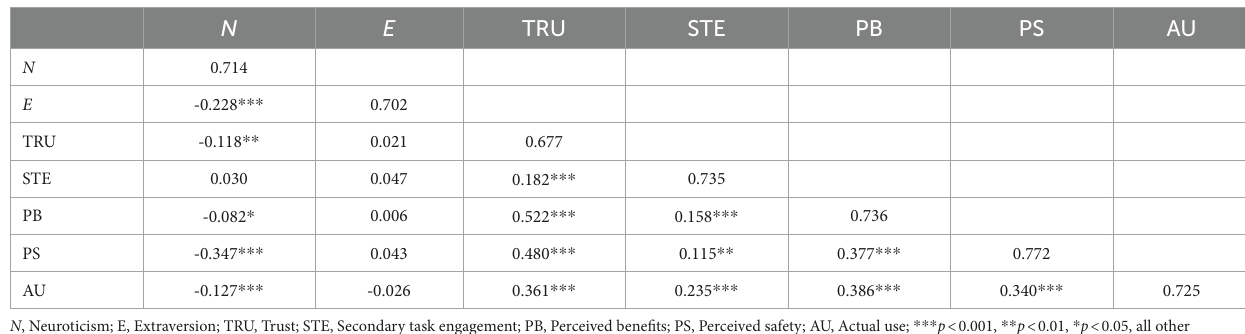
TABLE 5 Inter-construct correlation matrix.